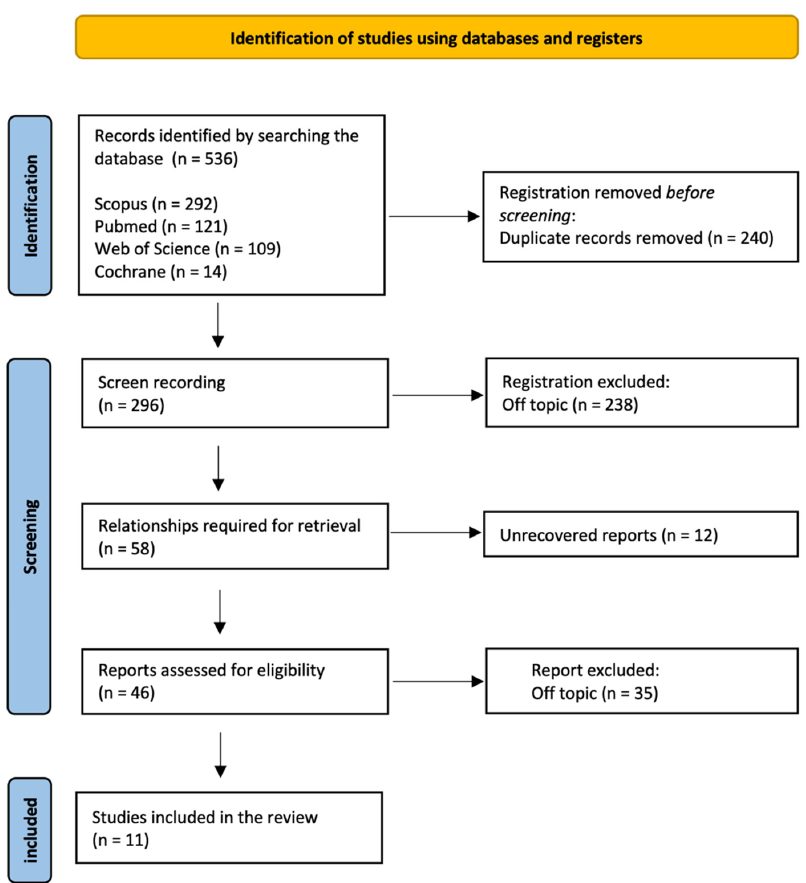
Figure 2. PRISMA flowchart diagram of the inclusion process.